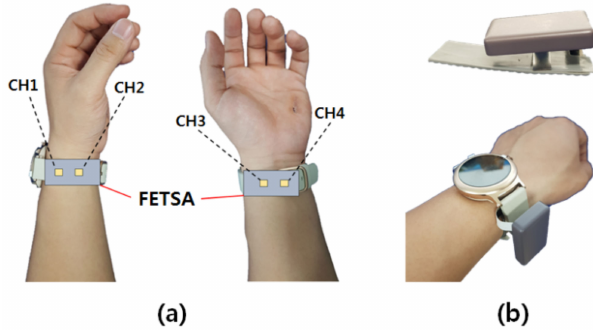
Figure 2. ( a ) Location of sensors. ( b ) How to wear the